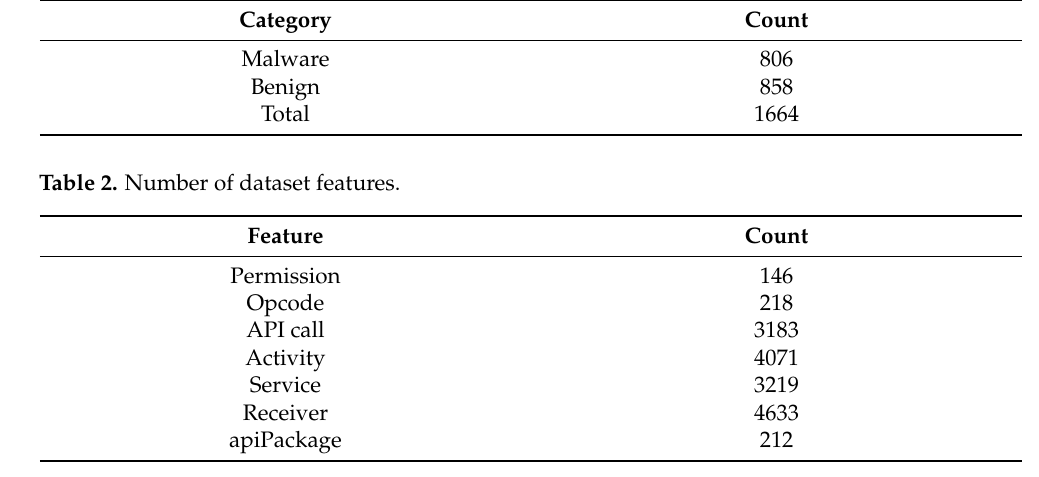
Table 1. Number of applications.